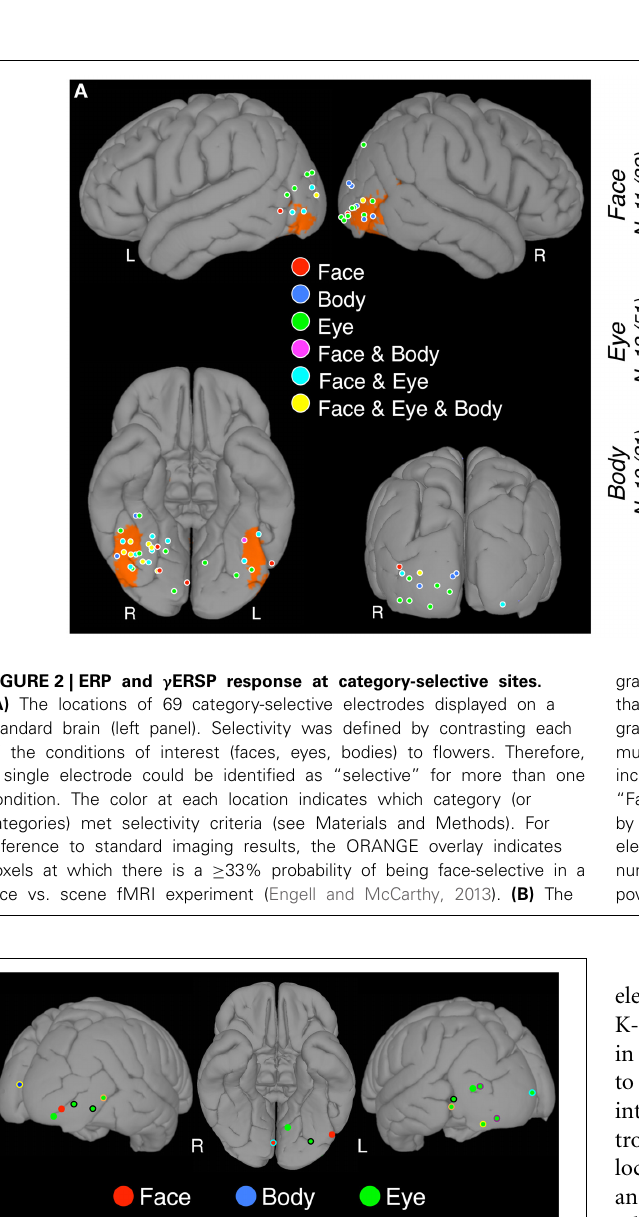
FIGURE 3 | Category-specific sites. The locations of category-specific electrodes overlaid on a standard brain. At these sites, the category-selectivity was determined by contrasting the condition of interest to all other conditions, not only flowers. Using this more conservative criterion we found three face-selective, thirteen eye-selective, and one body-selective site. A color border indicates electrodes that were contributed by the same patient. For instance, the orange border around the eye selective sites on the left and the right occipitotemporal cortex indicates that the same patient contributed these two